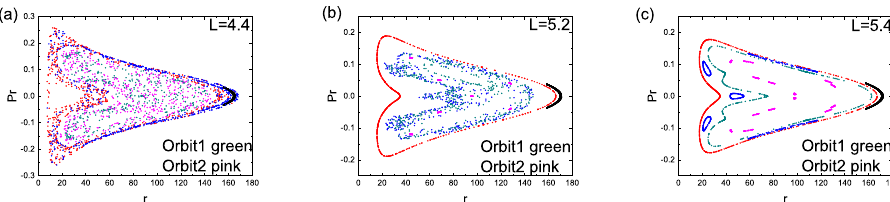
Figure 9. Poincaré sections. The parameters are E = 0.995, a = 0.1, B ∗ = 8 × 10 − 4 , and Q ∗ = 1 × 10 − 5 . Orbits 1 and 2 have their initial separations r = 75 and r = 95, respectively. The initial separations are r = 15 for the black orbit, r = 35 for the red orbit, and r = 55 for the blue orbit. The angular momenta in ( a – c ) are different.